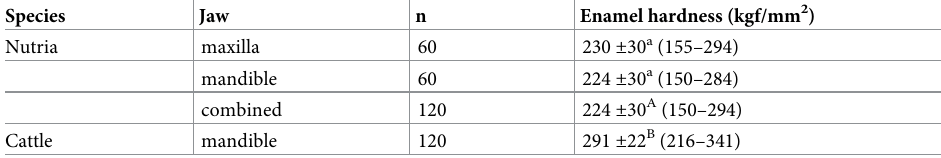
Table 1. Mean ± standard deviation (range) Knoop indentation hardness of incisor enamel of nutria ( Myocastor coypus ) and cattle ( Bos primigenius taurus